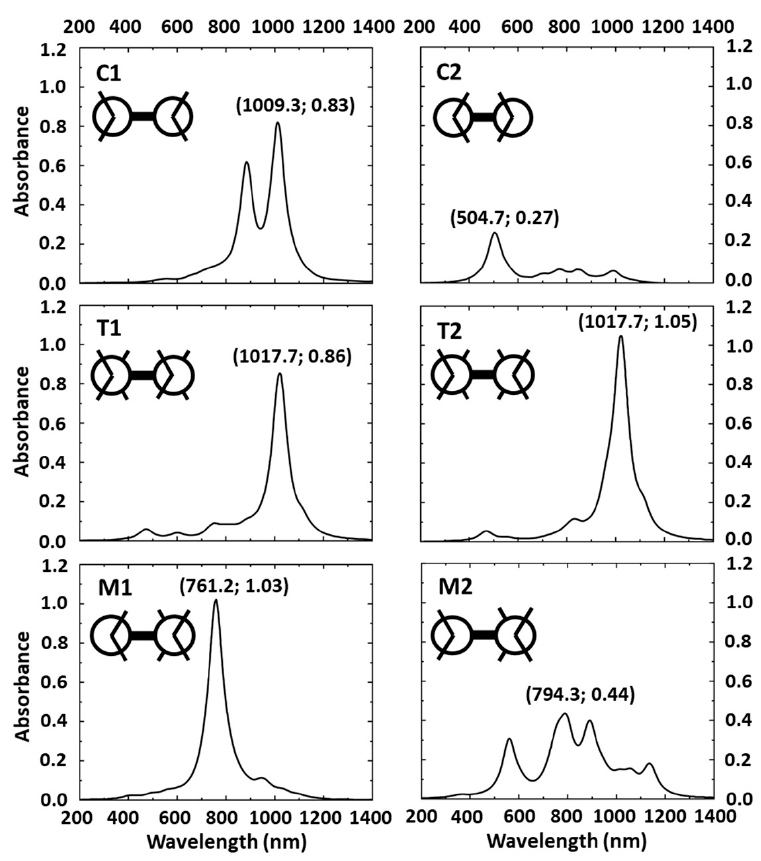
Figure 4. UV–Vis–NIR absorption spectra of six different configurations of [Pt(iPr 2 timdt) 2 ], calculated using the LDA/GW-BSE method.